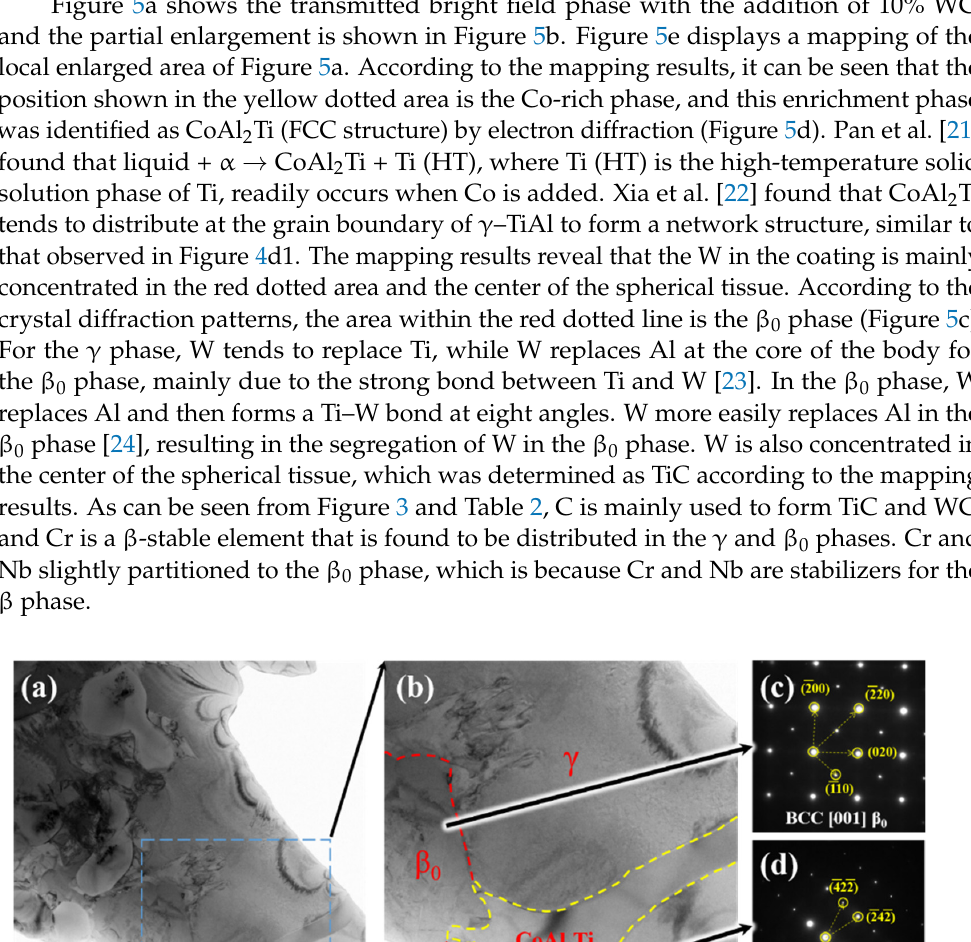
Table 2. Composition of the Ti–48Al–2Cr–2Nb composite coatings obtained from SEM ‐ EDS analy ‐ sis. Ti